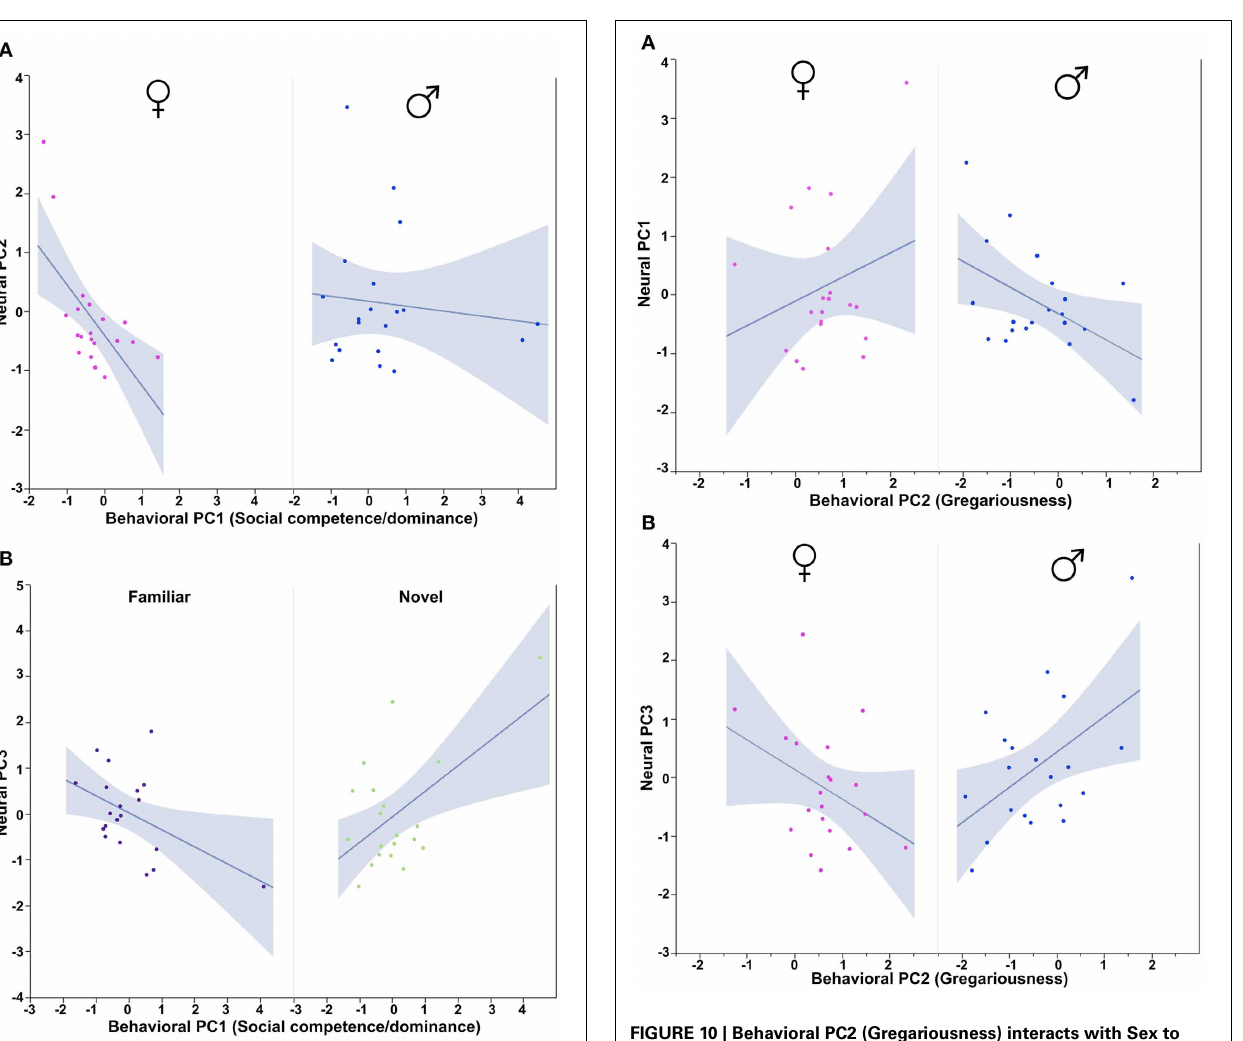
FIGURE 10 | Behavioral PC2 (Gregariousness) interacts with Sex to predict Neural PC1 and Neural PC3. (A) PC2 (Gregariousness) tends to correlate positively with Neural PC1 in females, but negatively in males. Sex × Behavioral PC2 F ( 1 , 32 ) = 4 . 09, p = 0 . 05. (B) An opposite pattern is observed for Neural PC3, such that Gregariousness tends to correlate positively with Neural PC3 in males, but negatively in females. Sex × Behavioral PC2 F ( 1 , 32 ) = 7 . 28, p = 0 . 01. The 95% confidence interval is indicated by shading. Finally, using Behavioral PC3 (Anxiety) as a covariate in a model for Neural PC1, we observe a significant Sex × Behavioral PC3 interaction [ F ( 1 , 32 ) = 4 . 01, p = 0 . 05; Figure 11A ]. The comparable model for Neural PC2 shows a trend for a Context × Behavioral PC3 interaction [ F ( 1 , 32 ) = 3 . 49, p = 0 . 07; Figure 10B ], and the comparable model for Neural PC3 yields significant interaction effects for both Context × Behavioral PC3 [ F ( 1 , 32 ) = 6 . 63, p = 0 . 01] and Sex × Context × Behavioral PC3 [ F ( 1 , 32 ) = 7 . 76, p < 0 . 01; Figure 11C